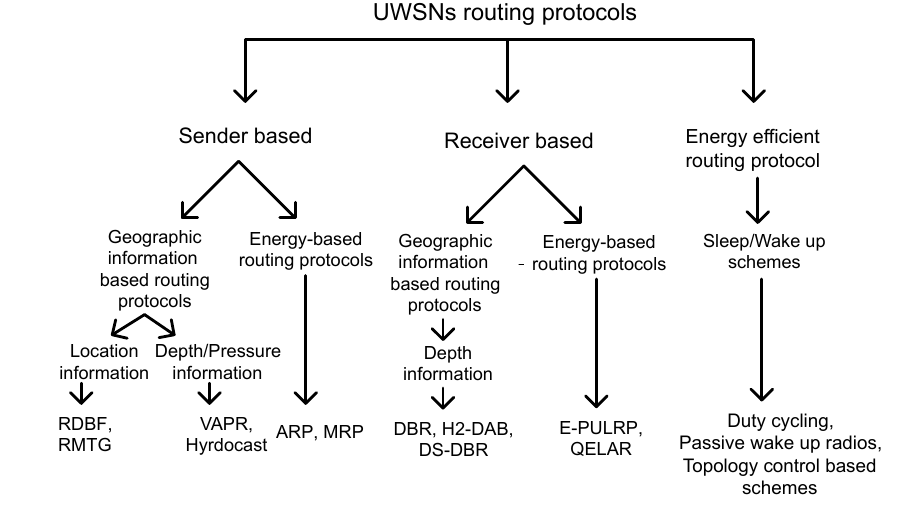
Figure 1. Classification of existing routing protocols. Table 2. Comparison of existing routing